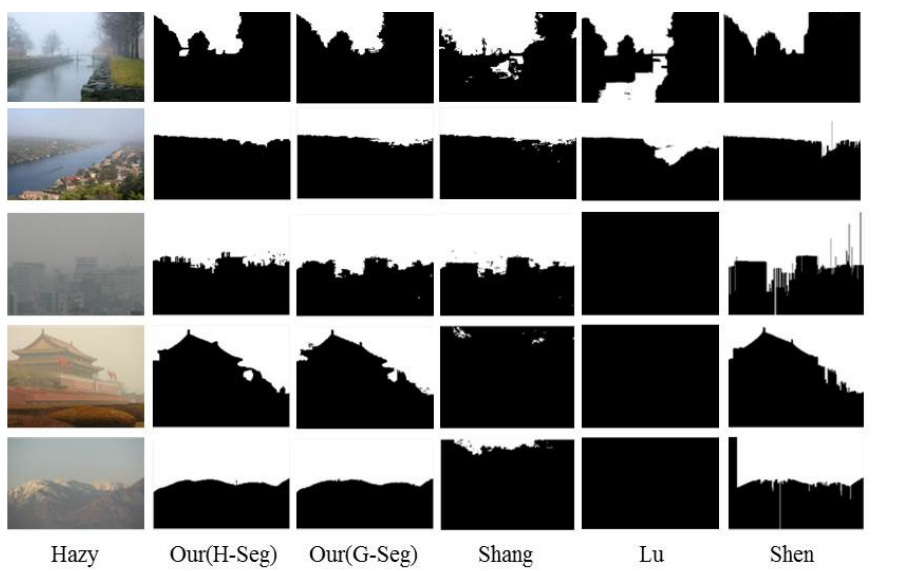
Figure 6. Sky detection results on the HazySky dataset. The first column is the hazy images. The second column to the last column are the results of Our(H-Seg), Our(G-Seg), Shang’s [14], Lu’s [6] and Shen’s [1] methods.